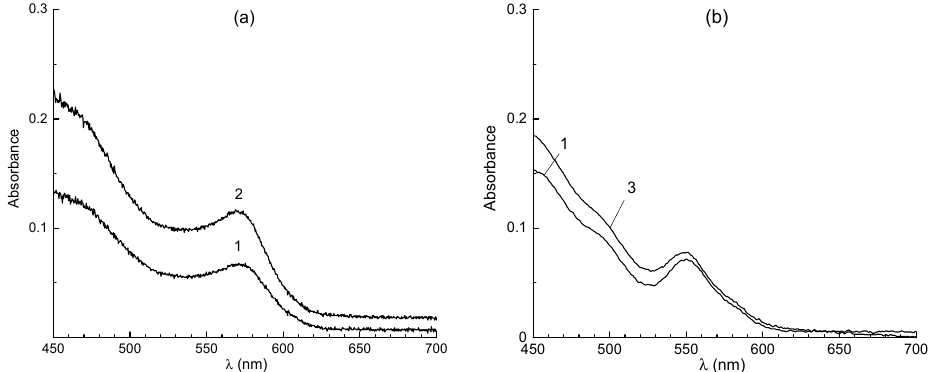
Figure 8. Absorption spectra of sols of nanocomposites (2.5 mg/mL) of PMMA with CdSe QDs ( a ) and CdSe/ZnS ( b ) in toluene: M1 (1), and T1 (2), M2 (3).